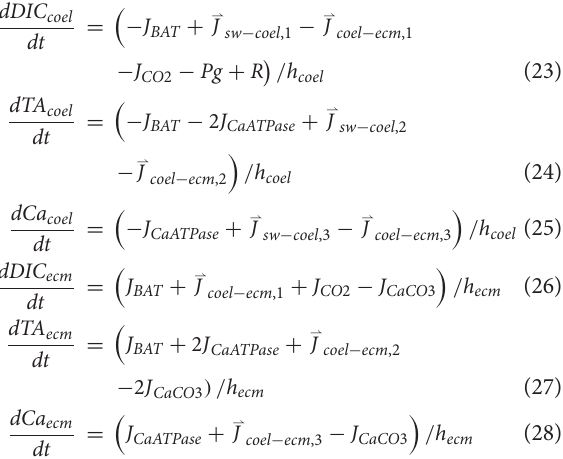
TABLE 3 | Summary of biologically-mediated and abiotic effects on calcification